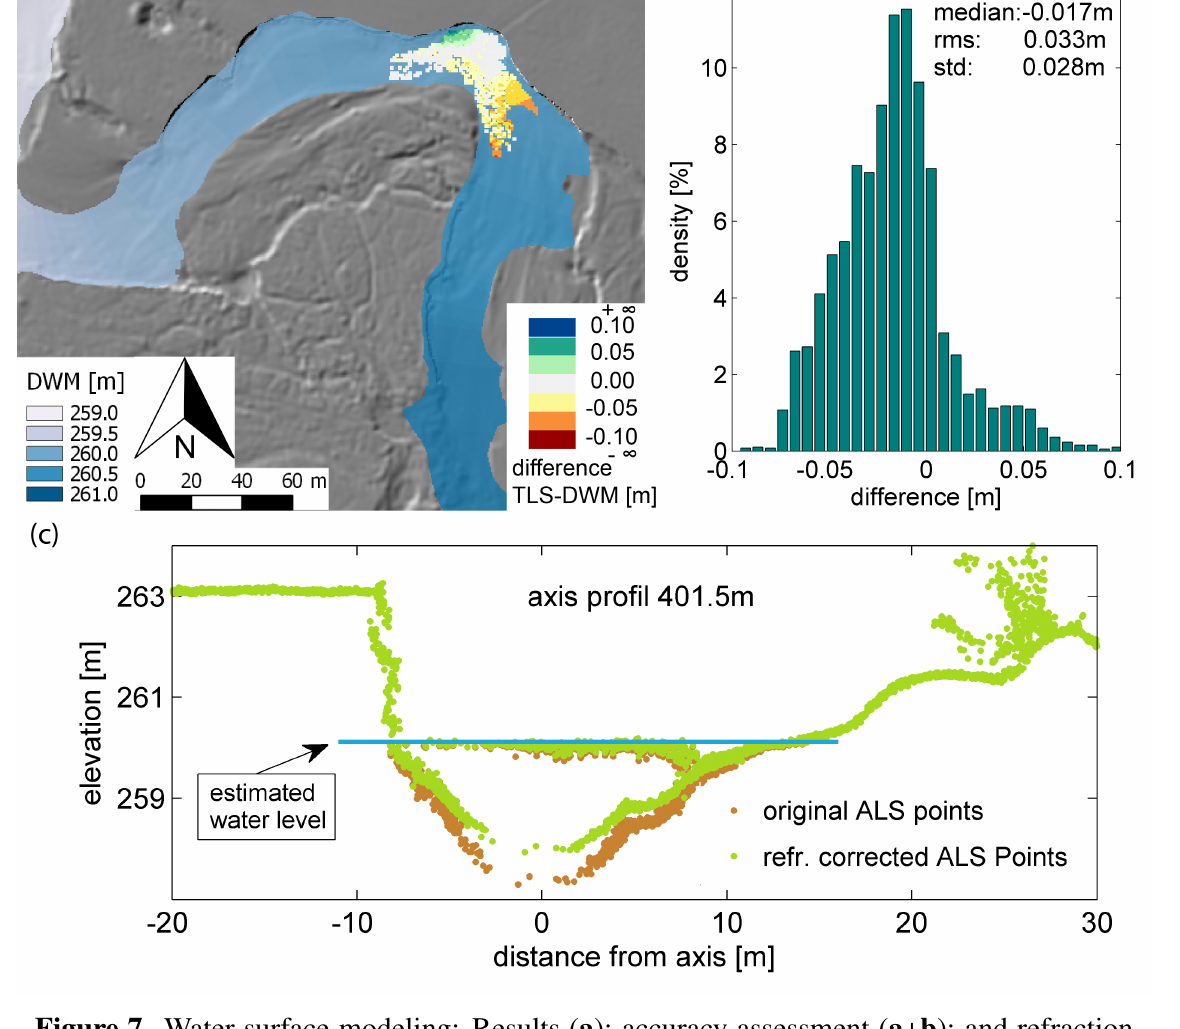
Figure 7. Water surface modeling: Results ( a ); accuracy assessment ( a + b ); and refraction correction effect ( c